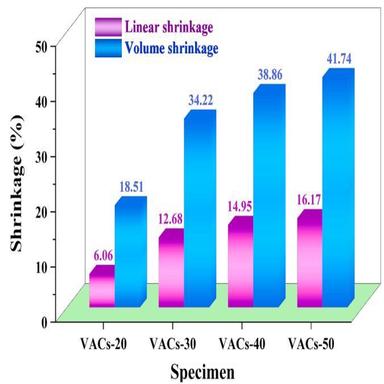
Linear and volume shrinkage of sintered VACs specimens.